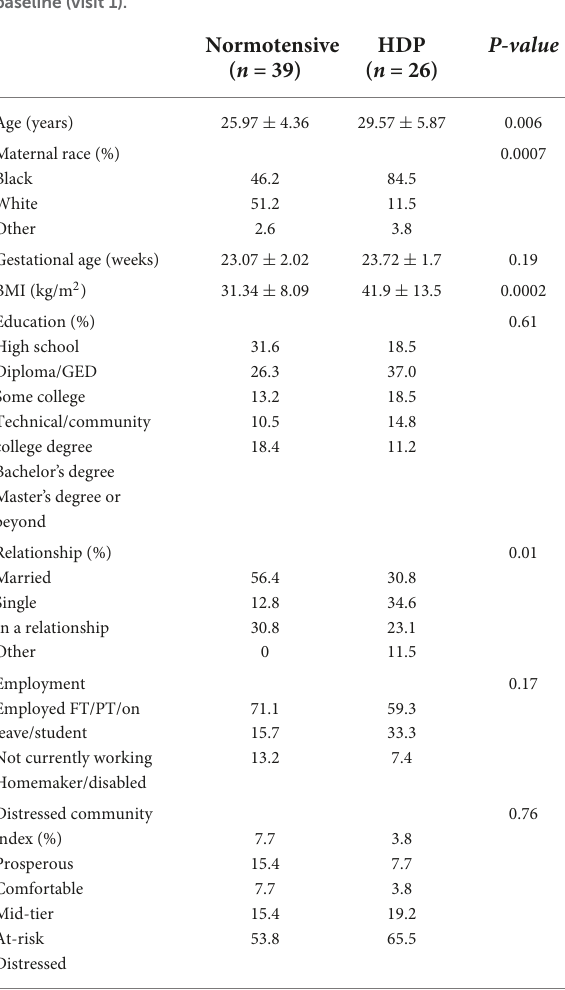
TABLE 1 Sociodemographic characteristics of study participants at baseline (visit 1).